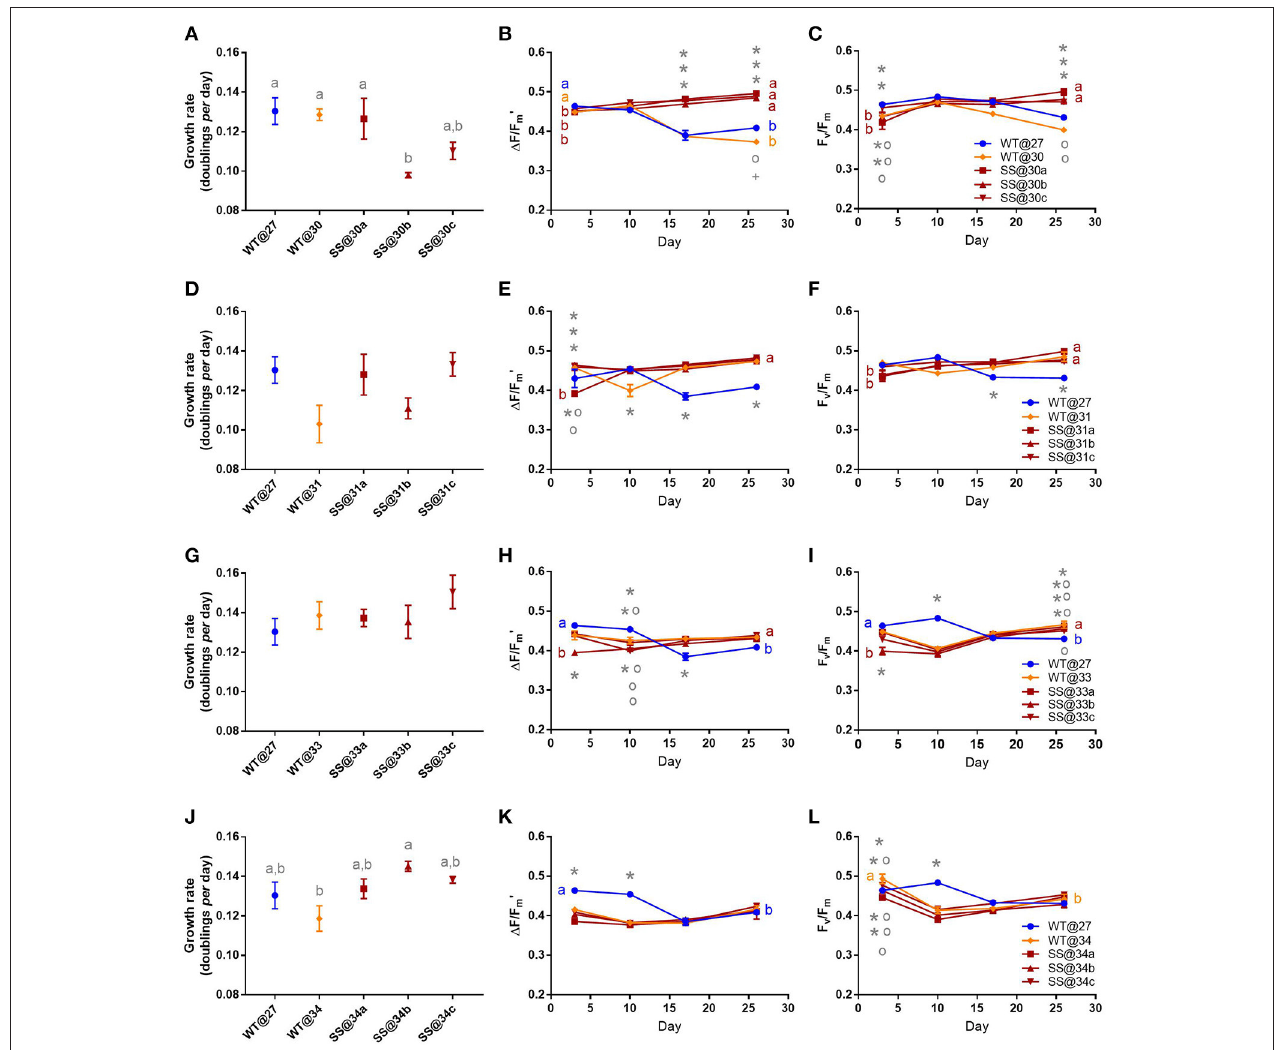
FIGURE 4 | Symbiodinium F1. Results of transplant experiment; comparison of mean ( ± SEM) growth rates (A,D,G,J) , effective quantum yields (B,E,H,K) and maximum quantum yields (C,F,I,L) between the wild-type (WT) Symbiodinium type F1 population at 27 ◦ C (WT@27), WT transferred into elevated temperature (WT@30, WT@31, WT@33, or WT@34) and the three selected Symbiodinium F1 populations (e.g., SS@34a, b, c). Populations’ were pre-acclimated for 14 days and growth rates were measured following 17 more days and quantum yield measurements over the following 26 days. Statistically significant differences among populations at a given time point are represented by different letters (A) or symbols above/below the mean points (B,C) . Statistically significant differences over time (between D3 and D26) are represented by different letters ( B,C , Tukey’s post-hoc tests; P < 0.05), n = 3 for all means. Where error bars are not visible, they are small and hidden by the